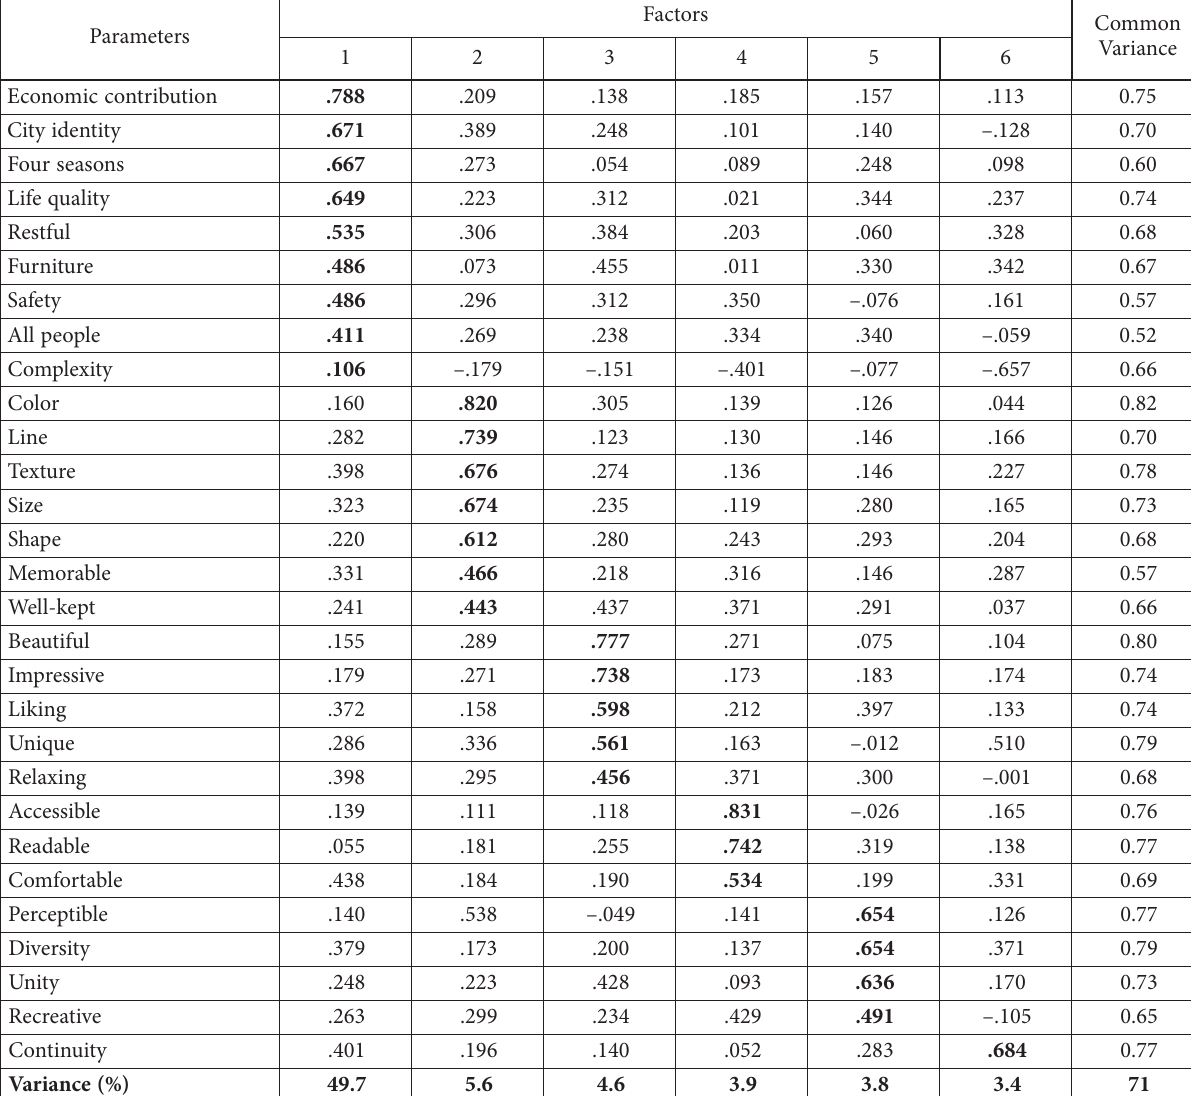
Table 5. The most effective parameters of space quality revealed by factor analyses